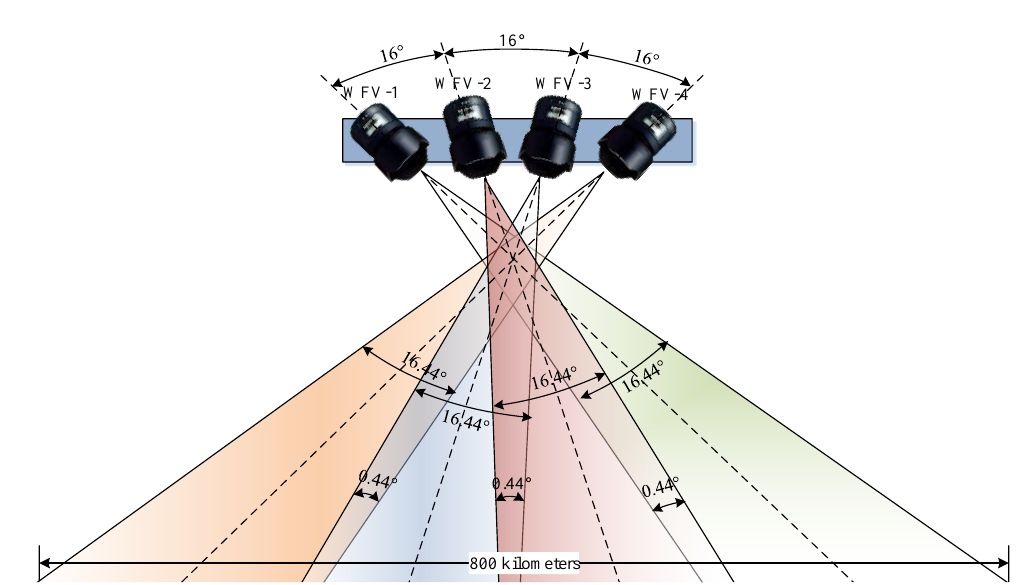
Figure 2 . Field design of the GF-1 WFV cameras. The field of view (FOV) of single camera is 16.44°, and the overlap FOV between adjacent cameras is 0.44°.